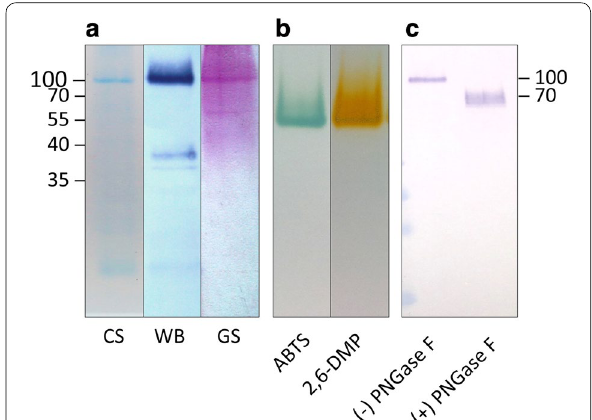
Fig. 4 PAGE analysis of purified Tvlcc5 synthesized in A. adeninivorans G1212/YRC102-TEF1-TVLCC5-6H. a Western-blot signal (WB), Coomassie (CS) and glycosylation staining (GS) of Tvlcc5 after separation on a 10% SDS-PAA gel. b Activity staining of Tvlcc5 separated on a clear native gel using ABTS or 2,6-DMP as substrates (no marker was used since separation in native gels is by size and charge simultaneously). c Comparison of the western-blot signals of Tvlcc5 and PNGase F treated